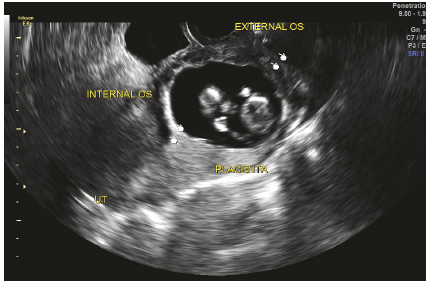
Figure 1: Transvaginal ultrasound: ultrasound imaging of viable cervical ectopic pregnancy. The fetus and placenta appear to be inferiorordistaltotheinternalcervicalos.Theexternaloshadabout 1 cm of functional length.